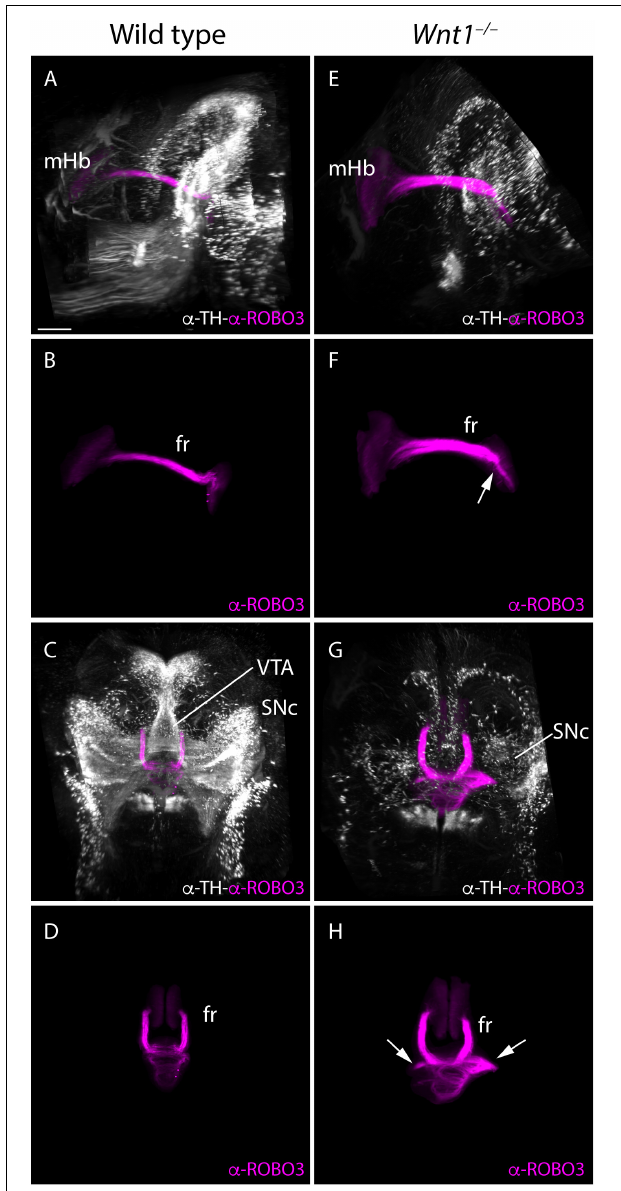
FIGURE 6 | 3D study of the fr and SNc phenotype in Wnt1 − / − . Lateral (A,B,E,F) and frontal (C,G,D,H) view of E18.5 wt (A–D) and Wnt1 − / − (E–H) brains labeled against TH (white) as SNc marker and ROBO3 (magenta) as mHb marker with iDISCO protocol. These 3D views allowed us to follow the trajectory of the mHb fr tract and its relation with the dopaminergic populations by TH. In the mutant (G,H) , we clearly observed the tract trajectory altered (arrows) and a drastic reduction of dopaminergic populations in the mid-diencephalic territory (E,G) . Six samples of each genotype have been analyzed. fr, fasciculus retroflexus; mHb, medial habenula; SNc, substantia nigra pars compacta; VTA, ventral tegmental area. Scale